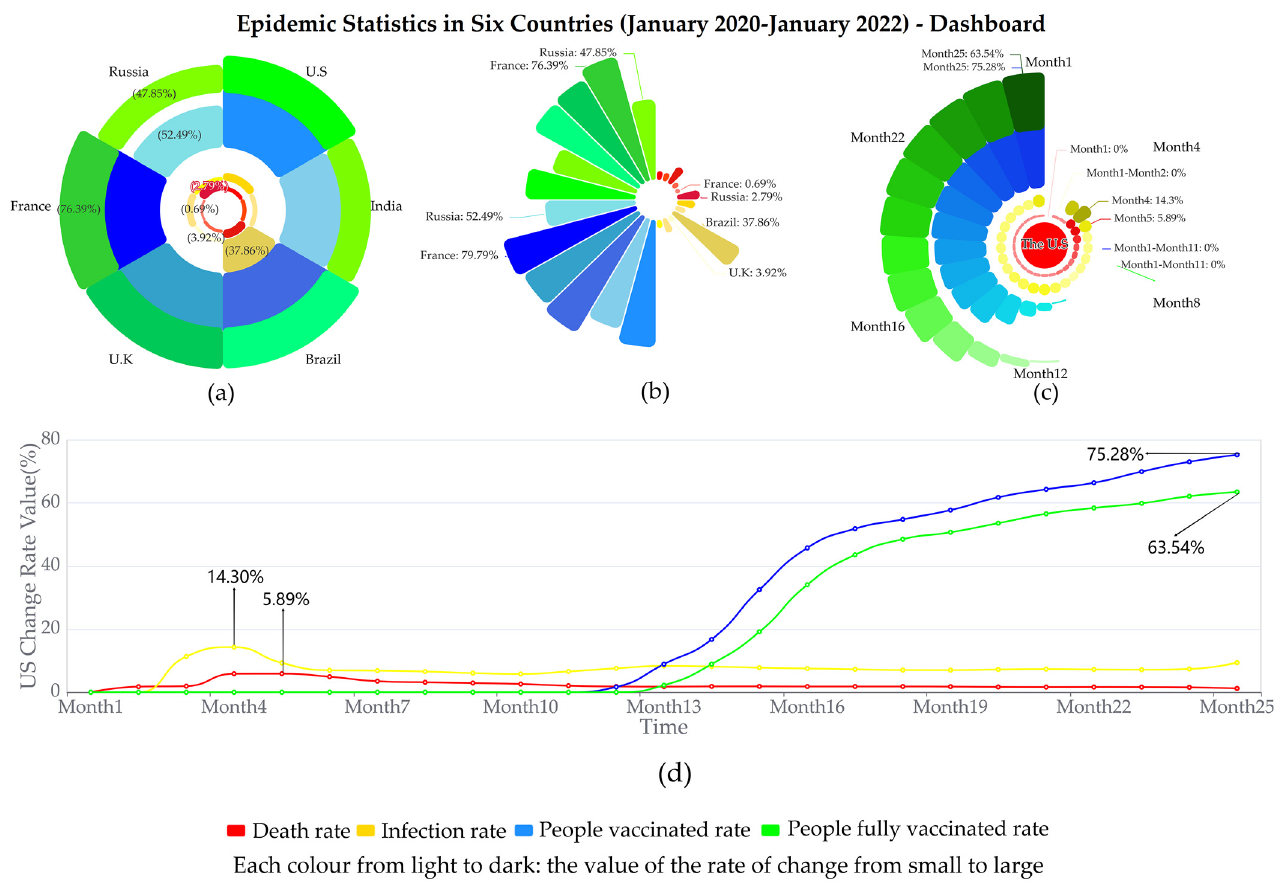
Figure 5. Epidemic statistics in six countries (January 2020–January 2022)-dashboard. ( a ) Stacked multidimensional rose chart. ( b ) Multidimensional rose chart. ( c ) USA data-combined stacked multidimensional and multidimensional rose charts. ( d ) USA data-line chart.